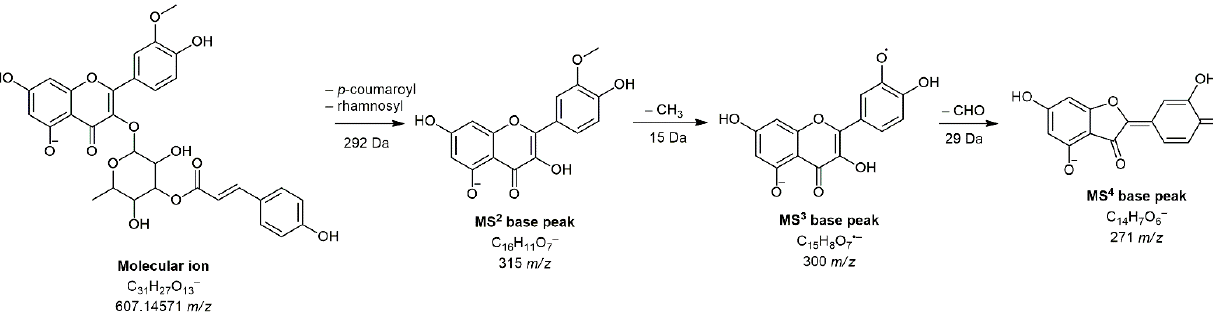
Figure 2. Proposed fragmentation pattern of compound 28 (isorhamnetin 3- O -(3 ″ - p -coumaroyl)-rhamnoside).